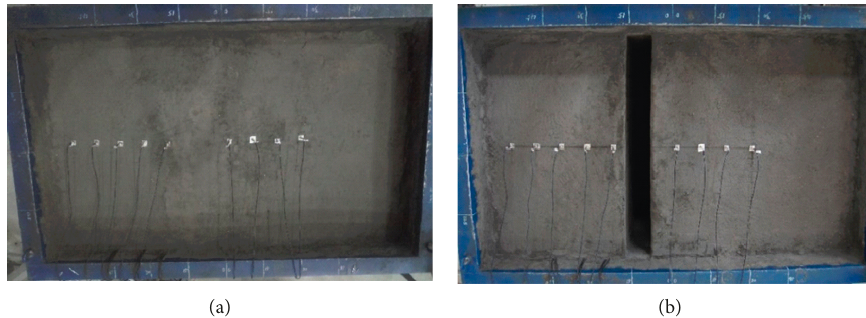
Figure 2: Test conditions: (a) without the open trench; (b) with the open